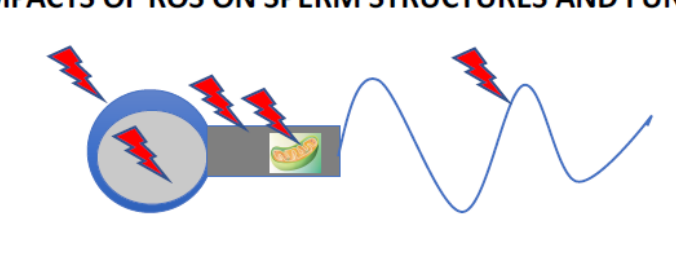
Figure 3. Known impacts of ROS on sperm structures and functions. ROS (red arrowheads above and within the schematized spermatozoa) have detrimental effects on sperm cells, resulting in changes in their structure and function. Peroxidation of membrane lipids affects the fluidity of the lipid bilayer, resulting in changes in sperm motility. Similarly, oxidative damage to enzyme complexes in the mitochondrial respiratory chain leads to changes in sperm motility. In an entirely different register, damage to the plasma membrane, whether from lipids, sugars and/or transmembrane proteins incorporated into the lipid bilayer, can alter the spermatozoa’s ability to interact with their target, the oocyte. At the same time, ROS (especially H 2 O 2 ) can disrupt the terminal signaling pathways of capacitation and acrosomal reaction, thereby disrupting the fertilization stage. Finally, by attacking nucleic acids, ROS induce a mutagenic risk that can be transmitted to the embryo and future generations if these alterations in the genetic and epigenetic information contained within the paternal nucleus/DNA are not effectively corrected by oocyte repair systems. These de novo mutations, created in the female germline but originating in the male, then increase the risk of abnormal development, the appearance of pathologies in the offspring and, in the long term, may lead to the genetic impoverishment of the species. Please refer to articles [13–15] for appropriate literature covering these aspects.